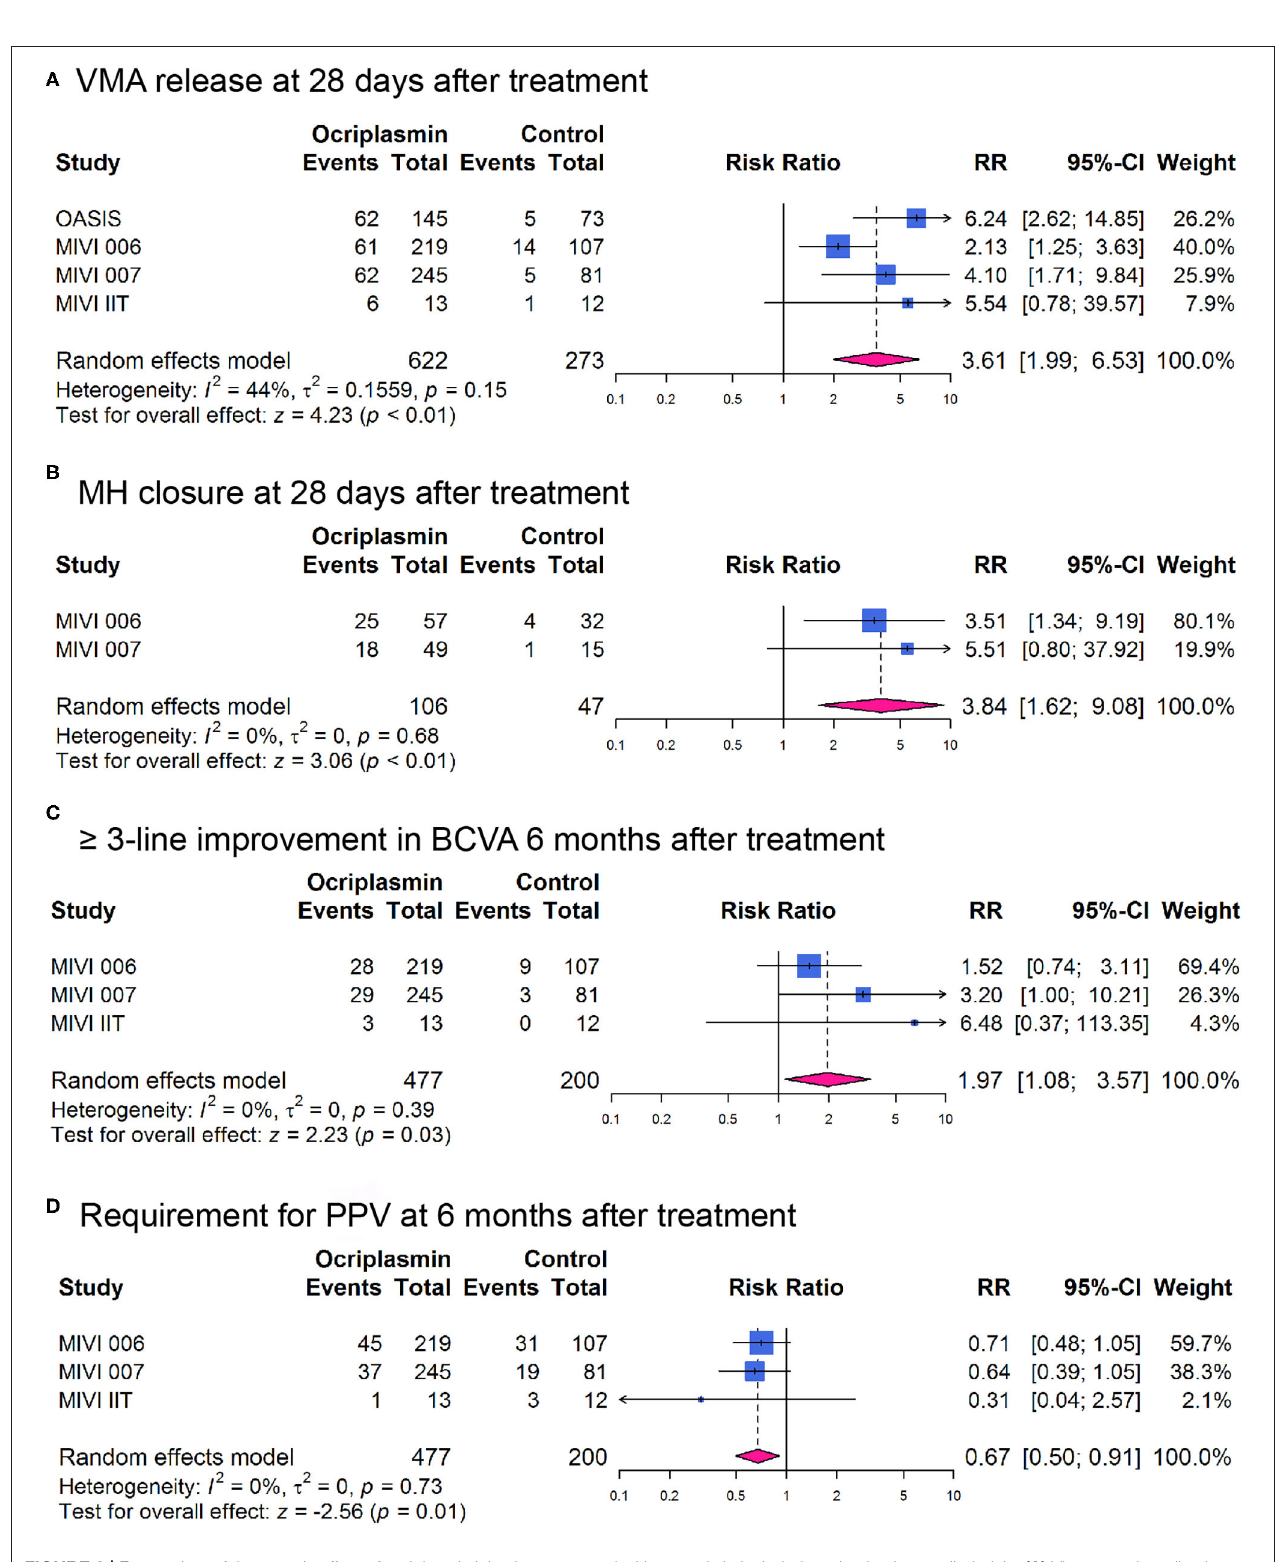
FIGURE 2 | Forest plots of therapeutic effect of ocriplasmin injection compared with controls in included randomized controlled trials. (A) Vitreomacular adhesion (VMA) release at 28 days after treatment; (B) Macular hole (MH) closure at 28 days after treatment; (C) At least 3-line improvement in best corrected visual acuity (BCVA) at 6 months after treatment; (D) Incidence of pars plana vitrectomy (PPV) at 6 months after treatment.